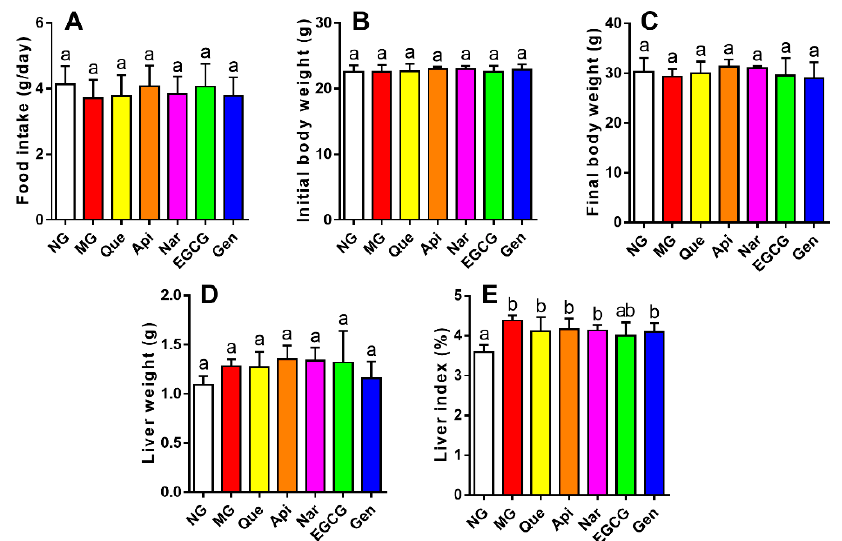
Figure 2. Effect of five kinds of flavonoids on food intake, body weight, liver weight, and liver index in mice. ( A ) Food intake; ( B ) initial body weight; ( C ) final body weight; ( D ) liver weight; ( E ) liver index. Values are expressed as the mean ± SD ( n = 10). Labeled means without a common letter differ ( p < 0.05). NG, normal group; MG, model group; Que, quercetin; Api, apigenin; Nar, naringenin; EGCG, epigallocatechin gallate; Gen, genistein. Table 1. Effect of five kinds of flavonoids on serum biochemical markers in mice 1 .